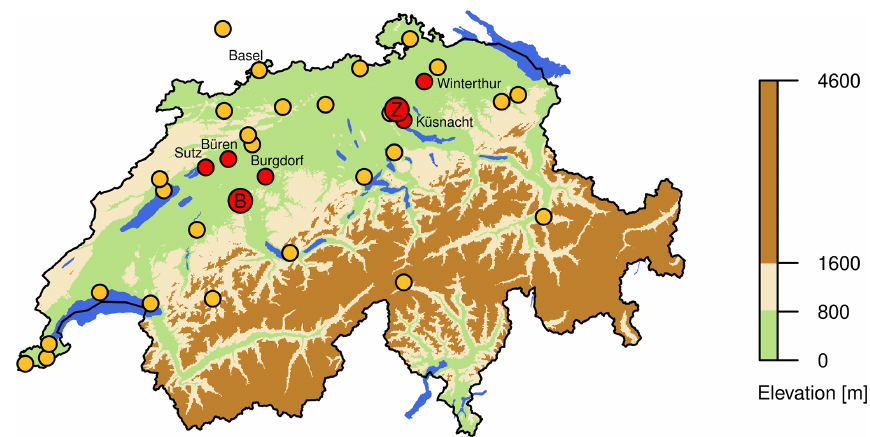
Figure 1. Map of Switzerland with the stations used in the homogenization (red: stations contributing to the Bern or Zurich series, gold: reference stations; the two larger points indicate the positions of Bern – B – and Zurich – Z). The background colors represent the topography and outline the three main geographical regions of Switzerland (Jura Mountains and the Swiss Plateau in the west and the north, Swiss Alps in the south). Geographical data were provided by the Federal Office of Topography –